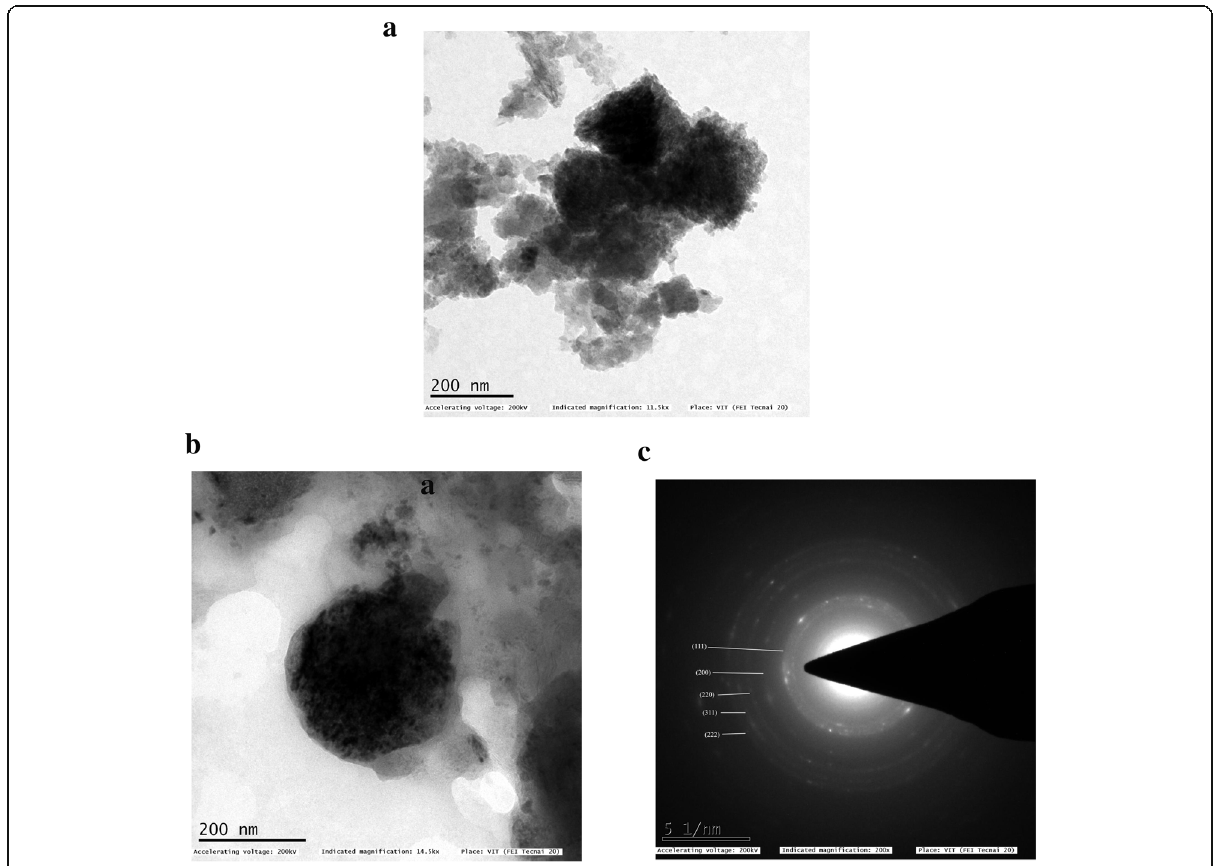
Fig. 6 a TEM micrograph of MgO nanoparticles synthesized with Pterocarpus marsupium heartwood extract at scale bar 200 nm. b TEM micrograph of single MgO nanoparticle at scale bar 200 nm. c SAED pattern of single magnesium oxide